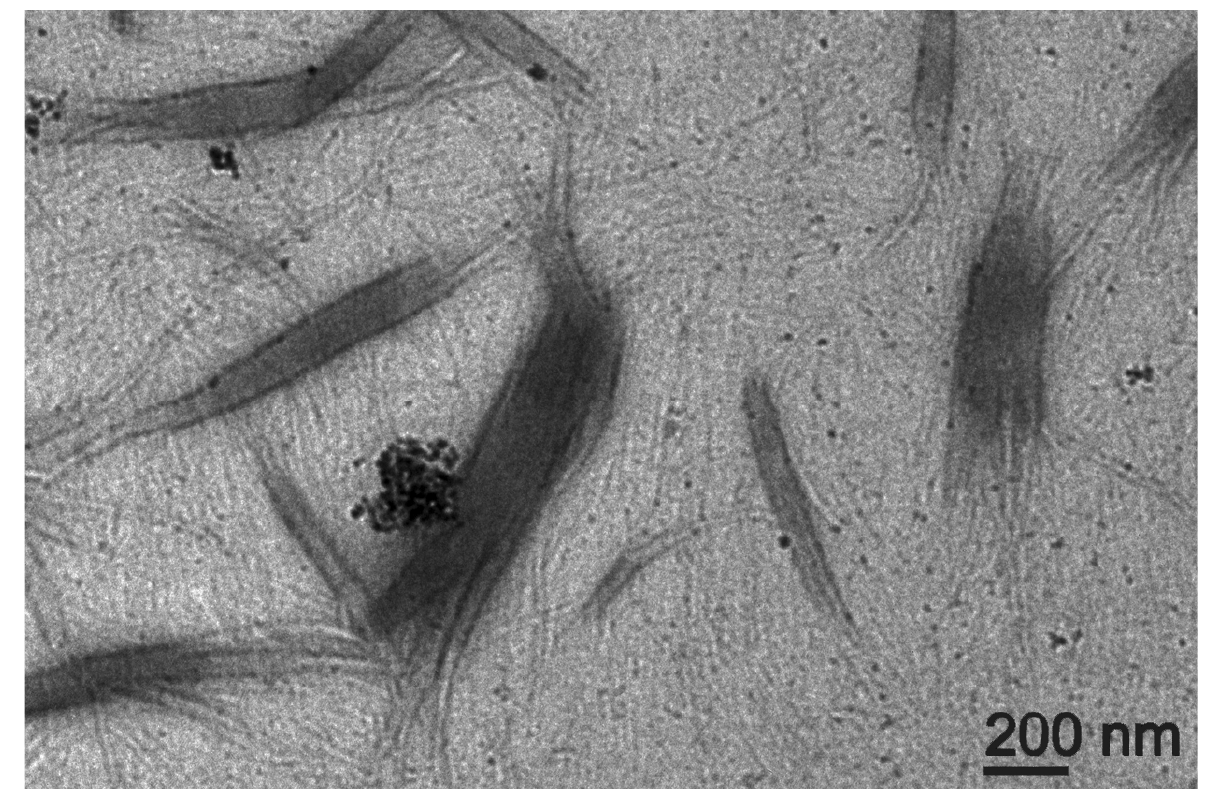
Figure 10. TEM micrograph of the nanocomposite supramolecular hydrogel formed by Lff in the presence of Lff ‐ PEG ‐ CNOs through the covalent approach.